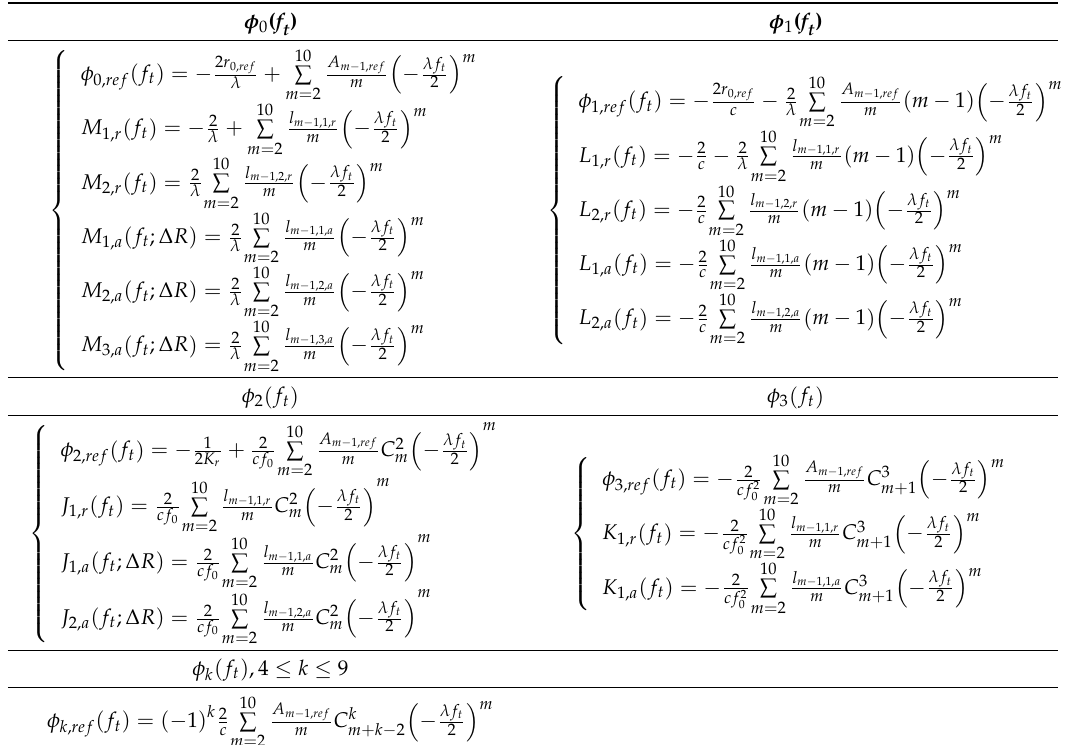
Table A1. Spatially variant coefficients in the 2D frequency